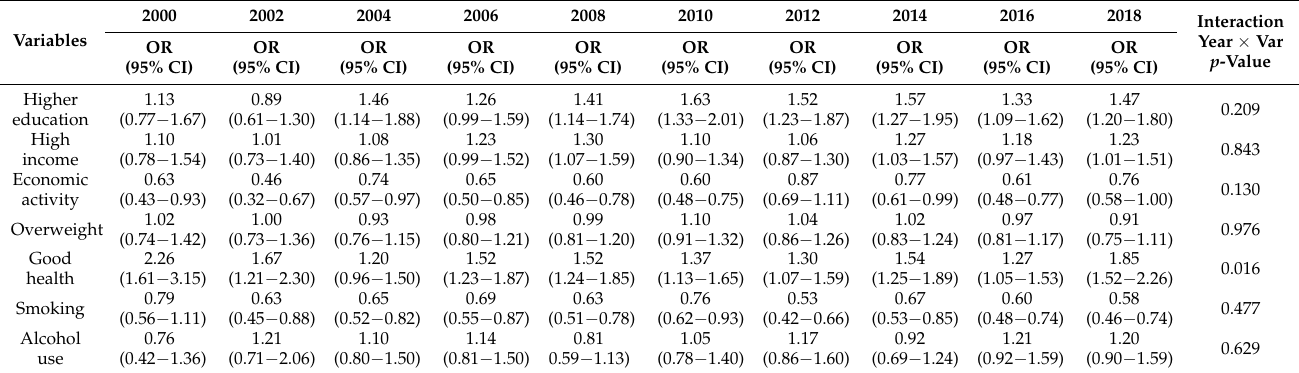
a The model was adjusted for gender, age and ethnicity. All explanatory variables were included in the model at the same time with interaction terms with study year (year as categorical variable), p -values for the interaction were obtained from the full model. OR—odds ratio, 95% CI—95% confidence